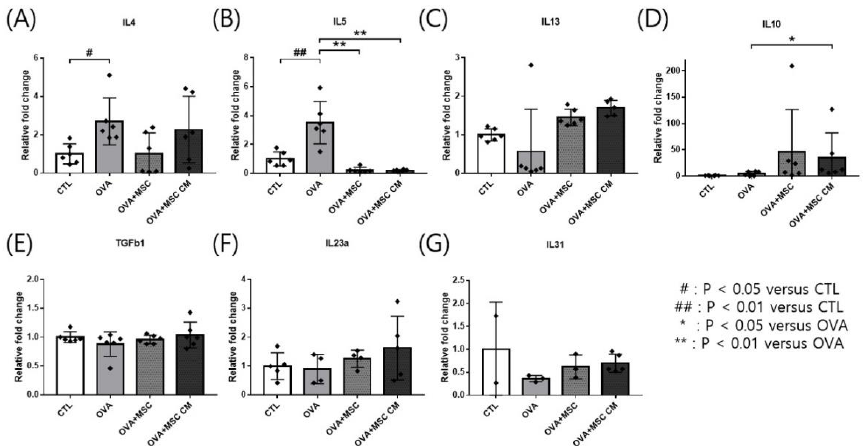
Figure 3. OVA challenge upregulated inflammatory cytokines and IL-10 transcription and MSC or MSC CM reversed the change in the ear skin. ( A ) IL-4, ( B ) IL-5, ( C ) IL-13, ( D ) IL-10, ( E ) TGF- β 1, ( F ) IL-23 α , and ( G ) IL-31 mRNA level changes in the ear skin measured by qPCR are shown. Each value indicates mean ± standard error of the mean. # p < 0.05 versus CTL, ## p < 0.01 versus CTL, * p < 0.05 versus OVA, ** p < 0.01 versus OVA. CTL, control; IL, interleukin; MSC, mesenchymal stem cell; MSC CM, mesenchymal stem cell culture medium; OVA, Ovalbumin; qPCR,